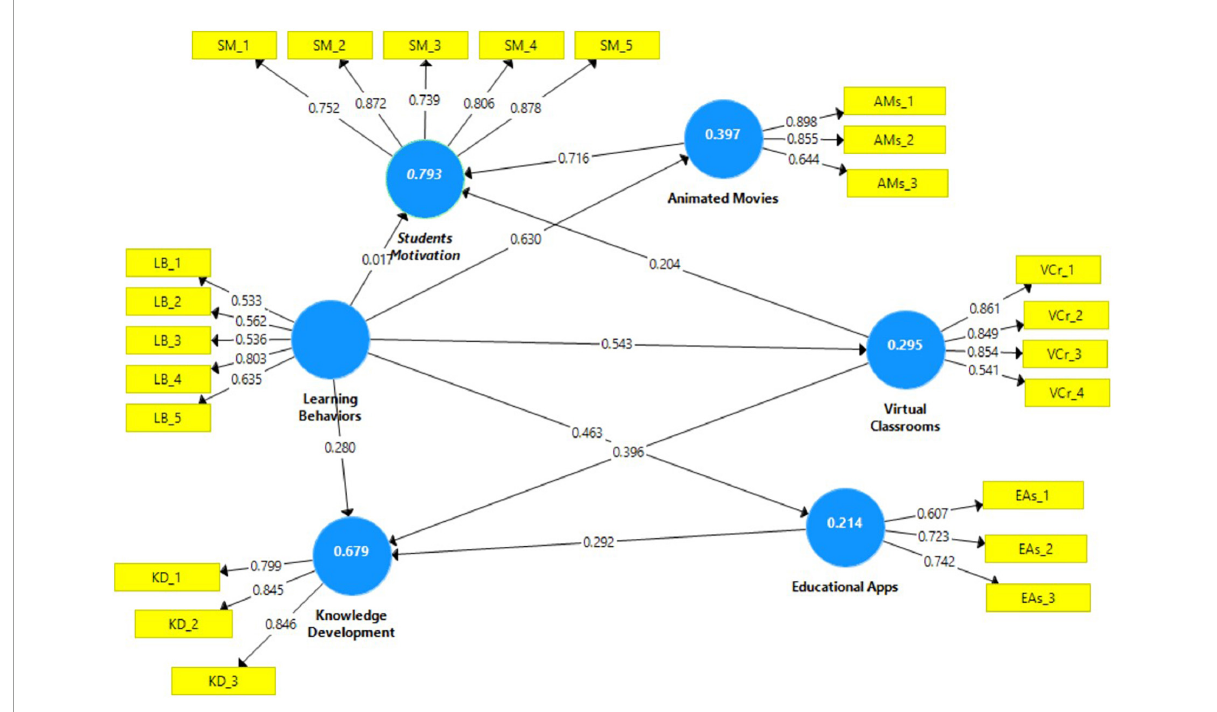
FIGURE2 PLS-structural equation modeling (SEM)